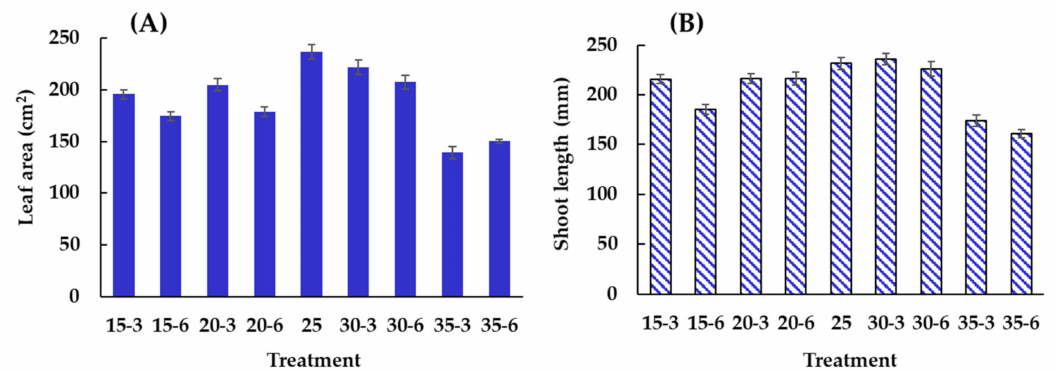
Figure 3. Leaf area ( A ) and shoot length ( B ) of coriander on day 18 after transplanting under di ff erent root-zone temperatures and stress periods. Data are shown as mean ± SE, n =